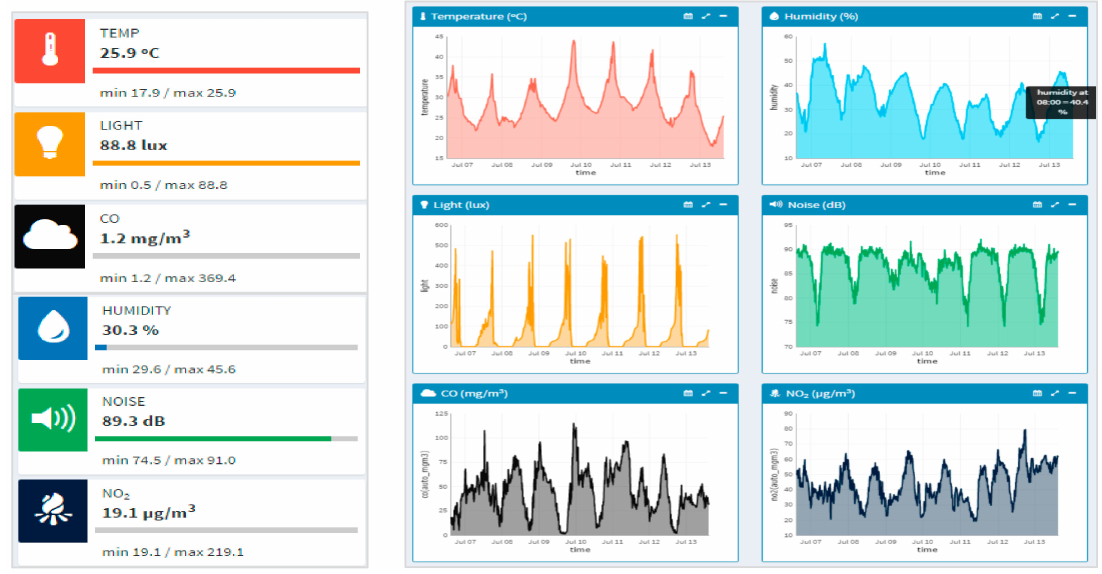
Figure 15. Overview of the environmental monitoring